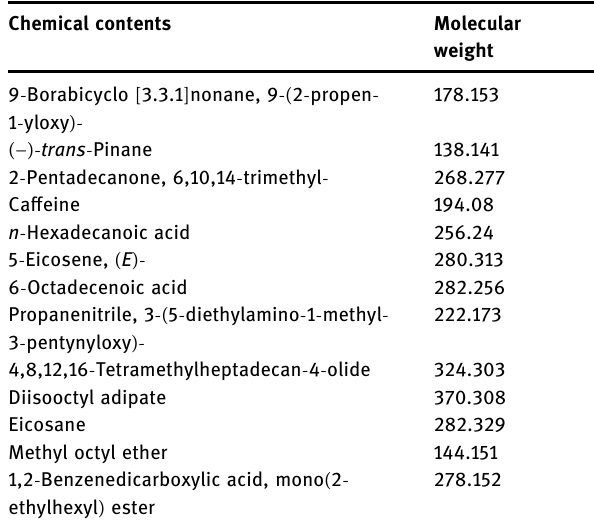
Table 2: The analysis of the chemical content of the R. vesicarius seed extract by the chloroformed